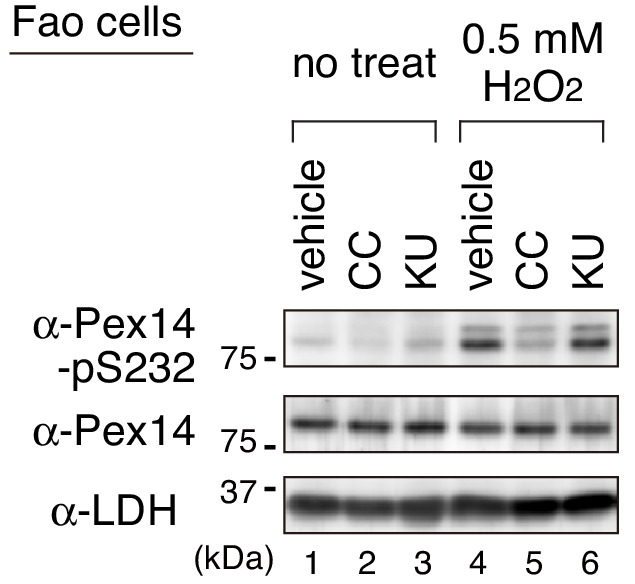
An ATM inhibitor KU-55933 shows no effect on the H2O2-induced phosphorylation of Pex14.Fao cells pretreated for 30 min with DMSO (vehicle), 10 μM Compound C (CC), or 10 μM KU-55933 (KU) were cultured for 1 hr in the absence (no treat) and presence of 0.5 mM H2O2. Cell lysates were analyzed as in Figure 1B by immunoblotting with the indicated antibodies.